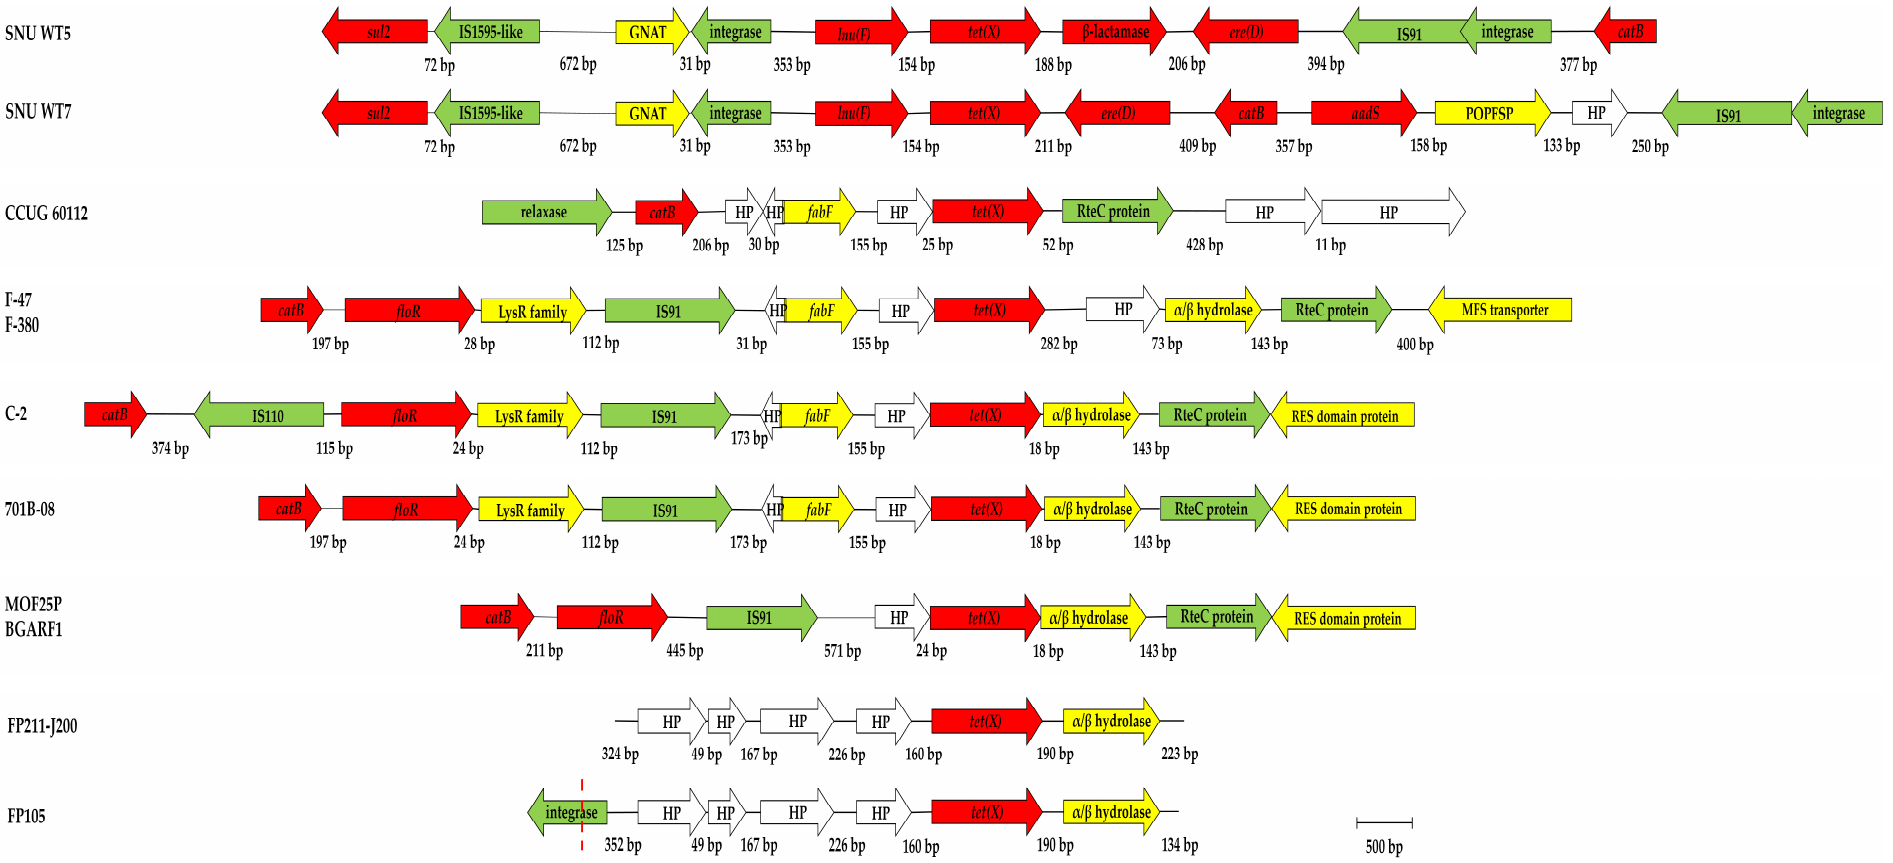
Figure 4. Comparison of the genetic environment of the tet (X) genes carried by Chilean Epilithonimonas strains (FP105 and FP211-J200) with the available tet (X) genes carried by Chryseobacterium and Flavobacterium strains isolated from fishes. Numbers between ORFs indicate the size of the intergenic region in base pairs (bp). The sequences used in the scheme were those included the GenBank under the accession numbers CP041687.1 ( C. sp. SNU WT5), CP044507.1 ( C. sp. SNU WT7), LFEG01000086.1 ( C. sp. MOF25P), LELA01000055.1 ( C. sp. BGARF1), JACXXP010000006.1 ( C. sp. C-2), PPEI02000003.1 ( C. oncorhynchi 701B-08), JACRUI010000001.1 ( F. kayseriense F-47), JACRUJ010000001.1 ( F. kayseriense F-380), MUHD01000006.1 ( F. plurextorum CCUG 60112) JAHTWS010000054.1 ( E. sp. FP105), and LSHB01000079.1 ( E. sp. FP211-J200). Resistome-related genes are in red. Mobilome-related genes are in green. Other genes are in yellow. Hypothetical proteins (HP) are in white.